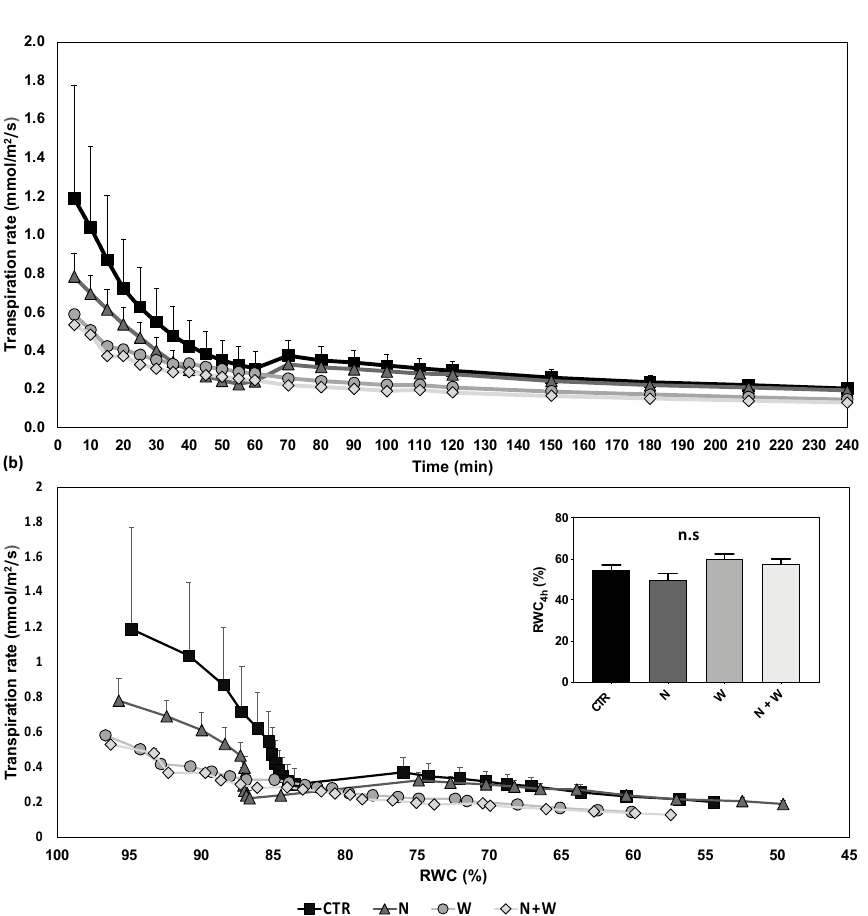
Figure 1. Transpiration rate as a function of time ( a ) and of relative water content ( b ) (RWC; insert ) in detached leaflets of tomato cv. Micro-Tom grown for 16 days under control (CTR; black; 10.5 mM N + 100% W), nitrogen deficit (N; dark grey; 5.3 mM N + 100% W), water deficit (W; light grey; 10.5 mM N + 50% W) or combined N and water deficit (N+W; white; 5.3 mM N + 50% W). Data presented are mean ± SEM (n = 6). n.s. above bars indicate nonsignificant differences according to Tukey’s HSD test ( p = 0.05).